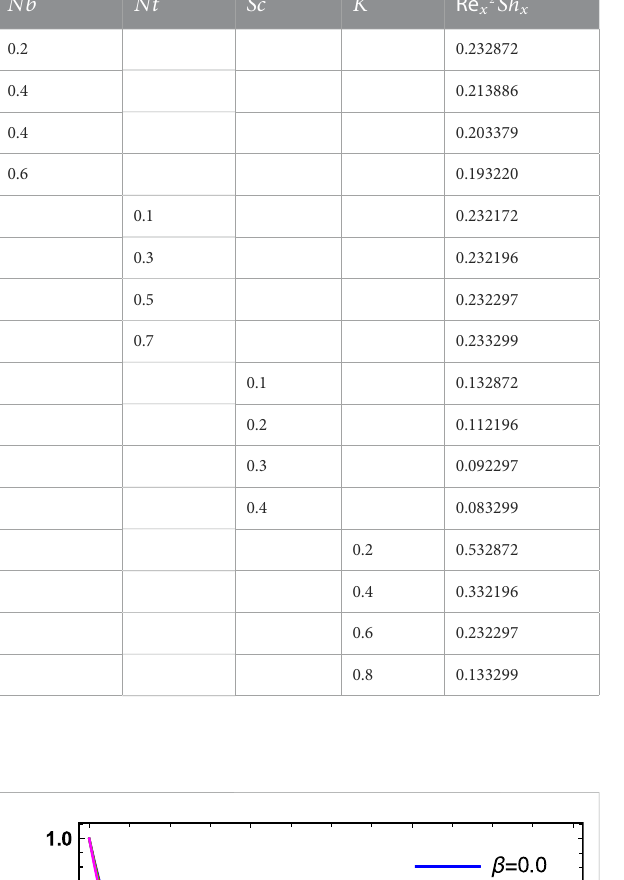
In fl uence of β on g ′ ( η ) .